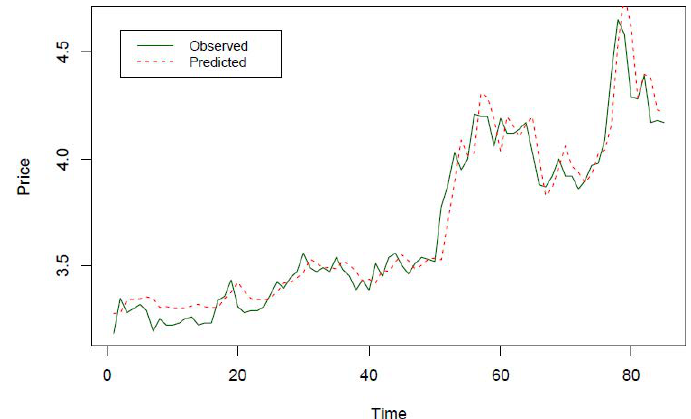
Fig. 2 Forecast of Bank of China